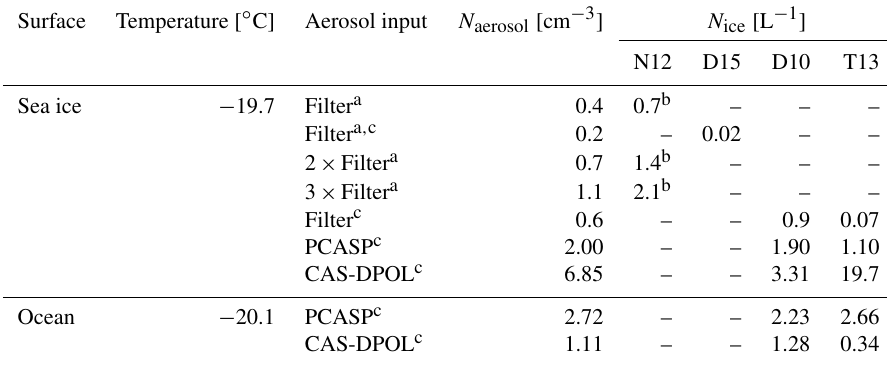
Table 3. Summary of inputs to and evaluations of the N12 (Niemand et al., 2012), D15 (DeMott et al., 2015), D10 (DeMott et al., 2010), and T13 (Tobo et al., 2013) parameterisations. Silicate dust concentrations derived from filter analysis presented by Young et al. (2016) are used to evaluate N12 and D15. No filter data are available over the ocean.